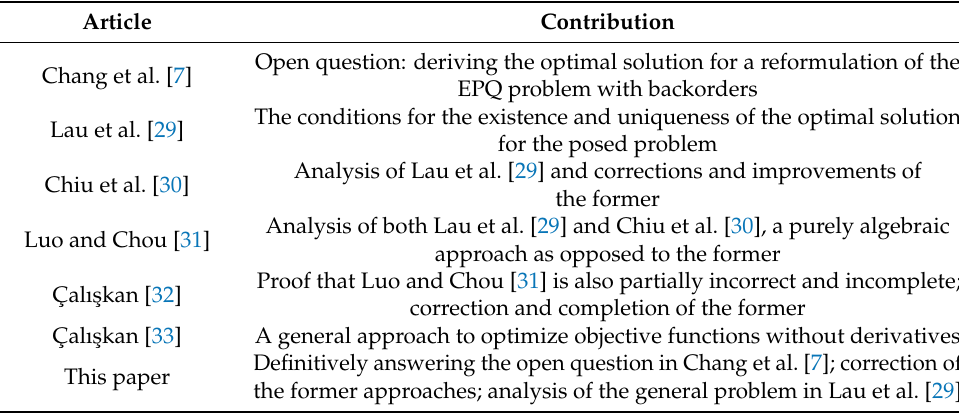
Table 1. Summary of the previous literature most related to the present